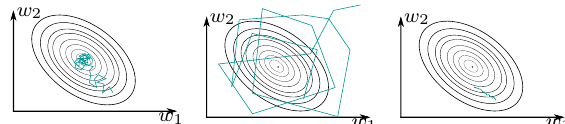
Figure 3. On the left side a neural network is shown with all neurons activated. On the right side a neural network is depicted where neurons get deactivated with a probability of p by a dropout layer to prevent overfitting.